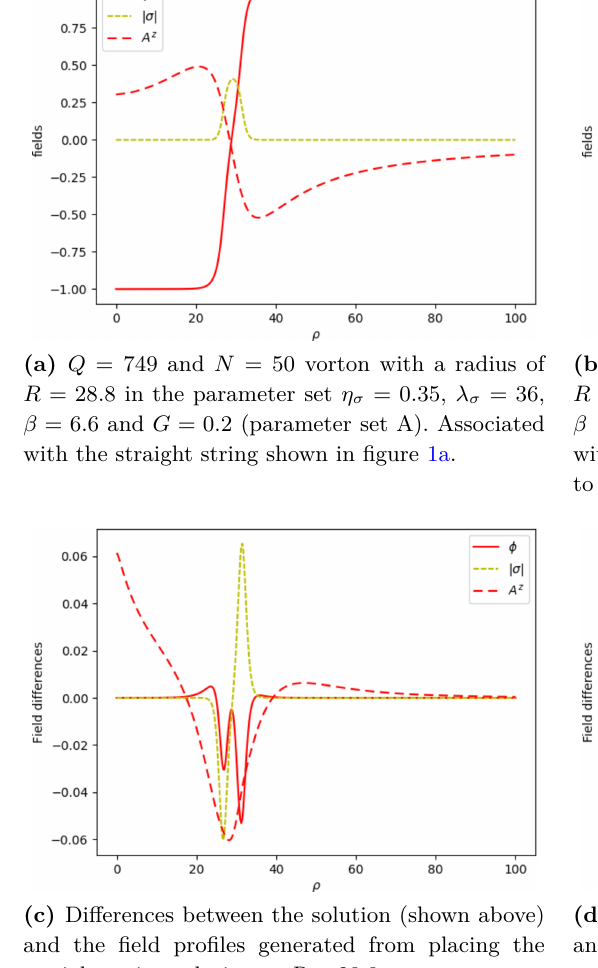
Figure 9 . The field profiles of two energy minimising vorton solutions (top) with the difference between them and the associated straight string profiles shown (bottom). It is important to note that the straight string profiles are placed at the correct vorton radius for comparison purposes and not at the predicted radius from the semi-analytic approach, which is slightly different.